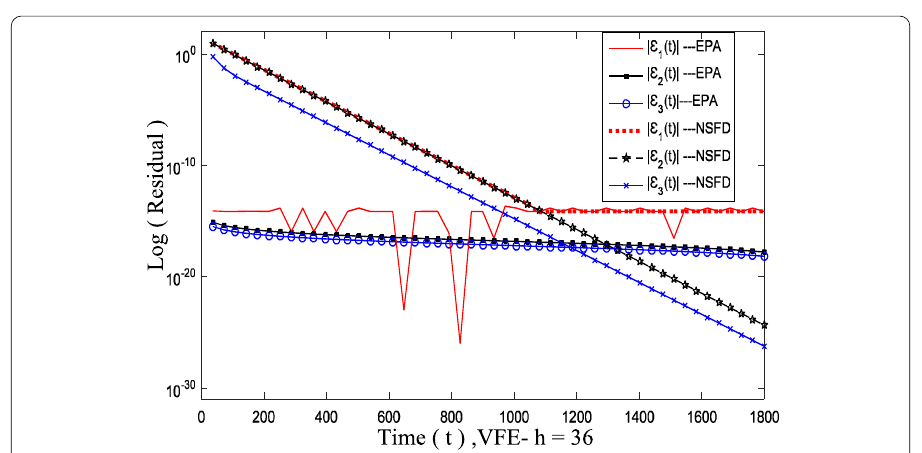
Figure 13 Absolute residuals of EPA and NSFD solutions at VFE for h =